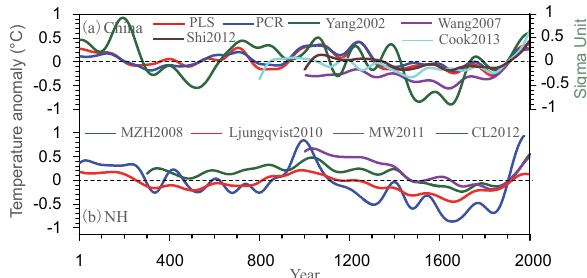
Fig. 3. Comparison of temperature reconstructions for China (a) and the Northern Hemisphere (b) . The reference period is from 1851 to 1950. The right-hand axis (marked “Sigma Unit”) is for the Yang et al. (2002) series. All color lines have been smoothed using a 100yr FFT